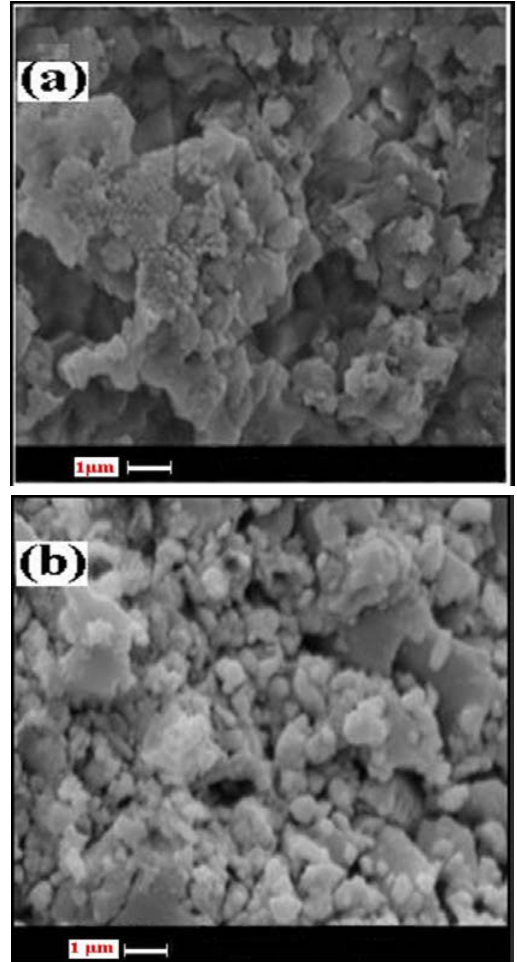
Fig. 3 . Electron microscope images for samples with different thickness: (a) sample C